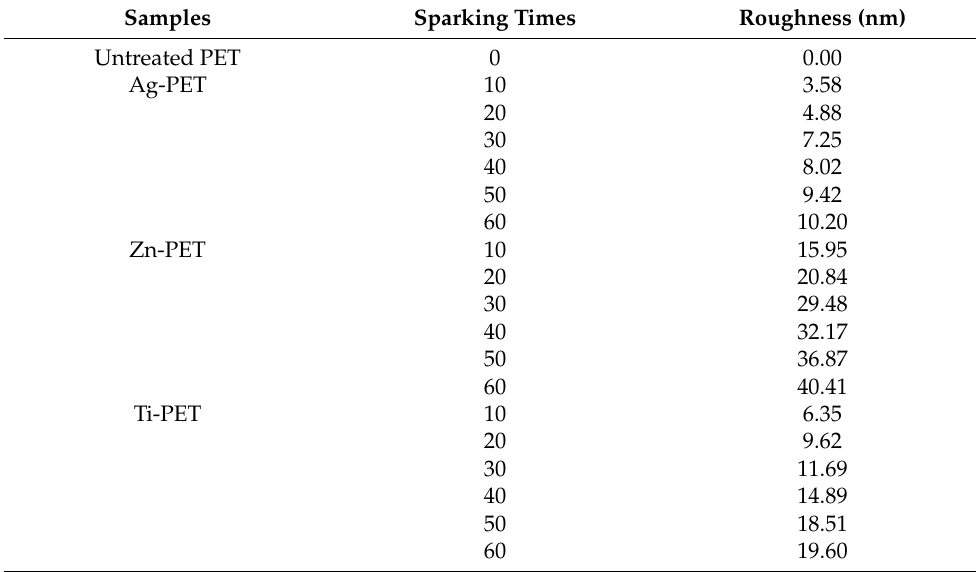
Figure 3. Field emission scanning electron microscope (FESEM) (magnification: 50,000 × ) with X–ray element mapping of the Ag-PET ( a ), Zn-PET ( b ), and Ti-PET ( c ) films treated 60 times. Table 1. Roughness of the Ag-PET, Zn-PET, and Ti-PET films treated 0–60 times.